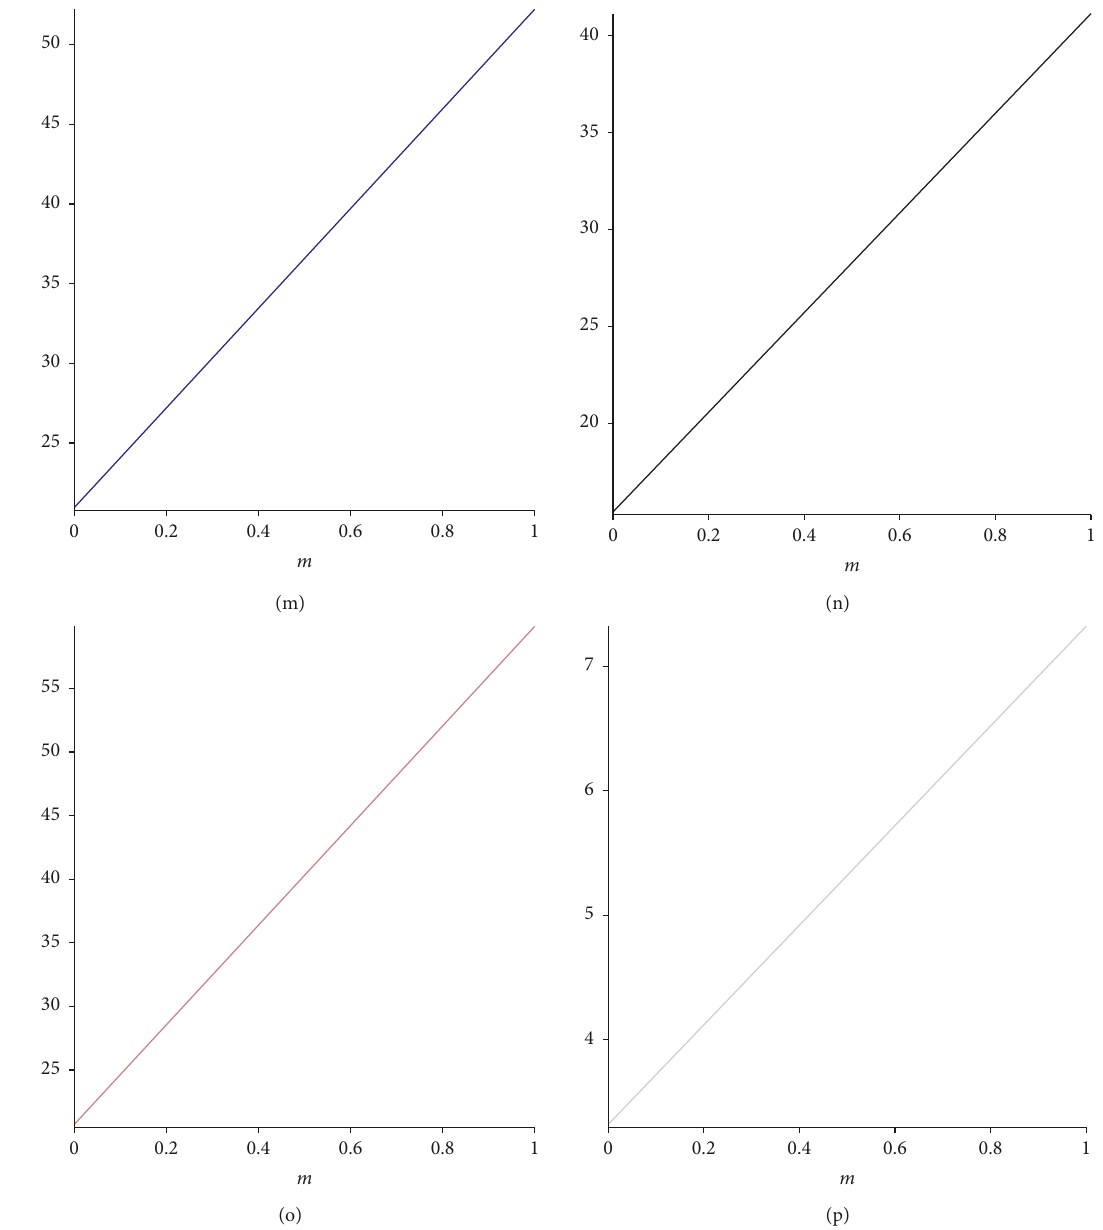
Figure 3: (a) VAR ( m − BiI ) ; (h) IRB ( m − BiI BiI 3